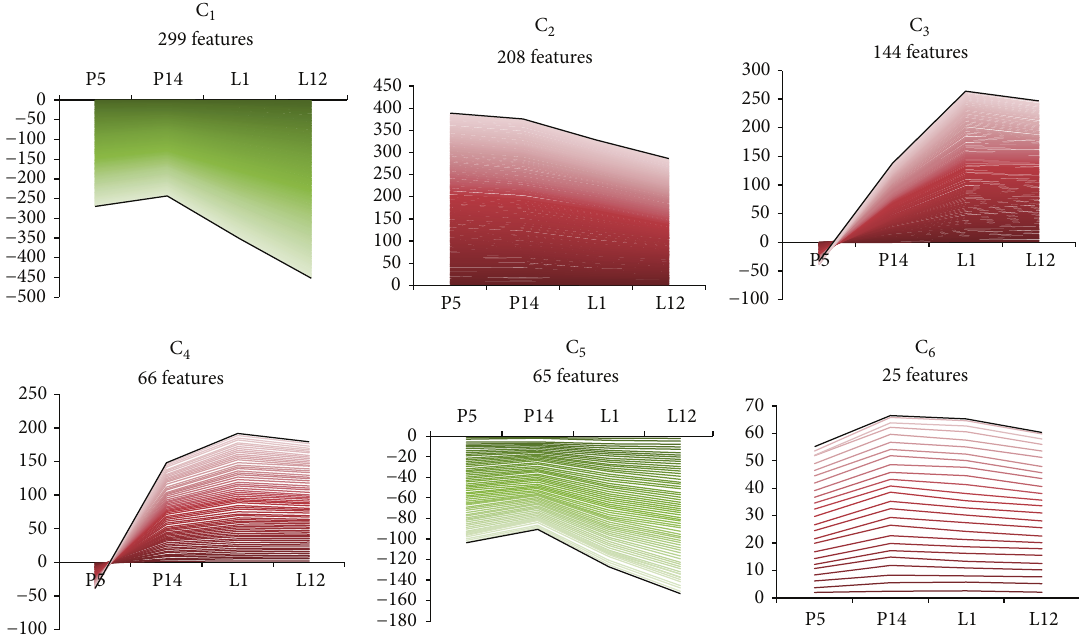
Figure 3: Unsupervised hierarchical clustering of the differentially expressed gene list. Gene expression profiles. Gene expression data from the 807 tags comprising the significant altered gene transcript list ( z -score > ± 1.50) were best represented by six clusters consisting of distinct up (red) and down (green) patterns of expression. Developmental stage time points and fold change are indicated on the x - and y -axes, respectively. The number of features (genetic elements) in each cluster is indicated. A black pseudoline representing the general (average) pattern of expression has been superimposed on each